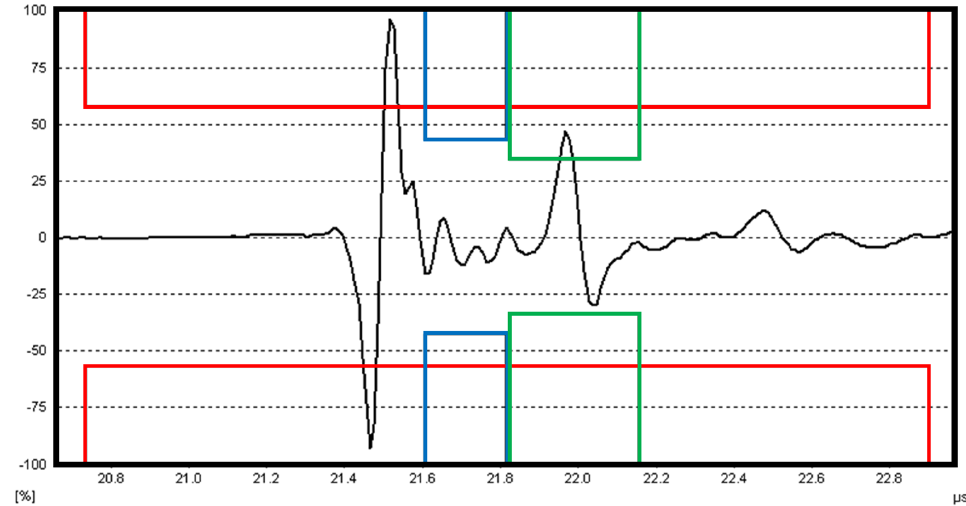
Figure 3. The exemplary A-scan recorded from a defect-free region of the plate.